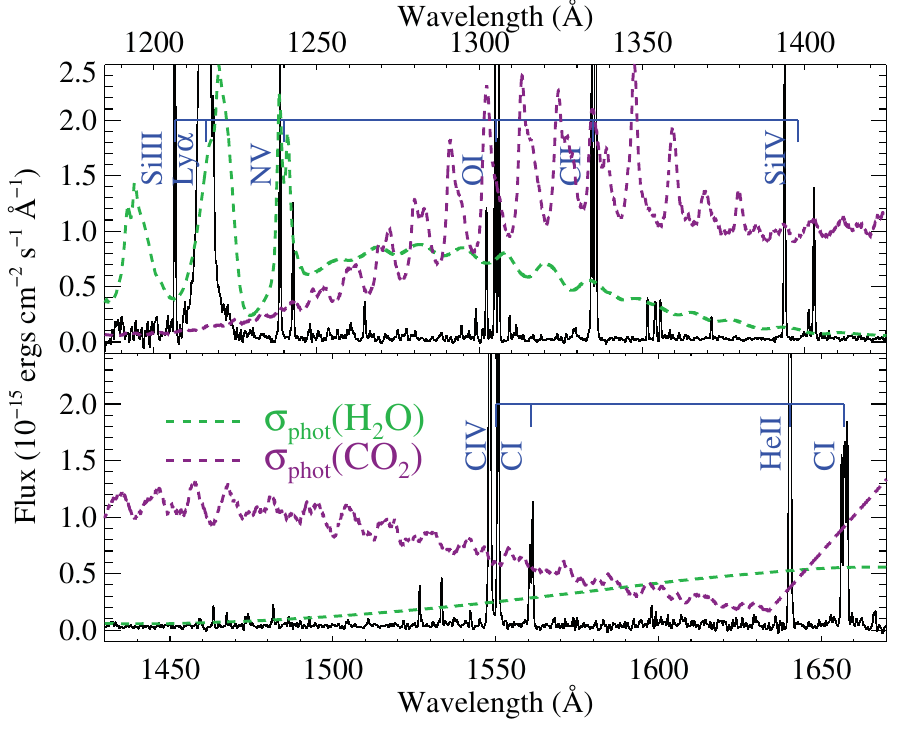
Figure 3. HST/COS spectrum of GJ876 (black) with superimposed photoabsorption cross-sections of H O (green) and CO (purple) superimposed. The Lyman- α flux is far 2 2 above scale. Figure from France et al. with copyright permission